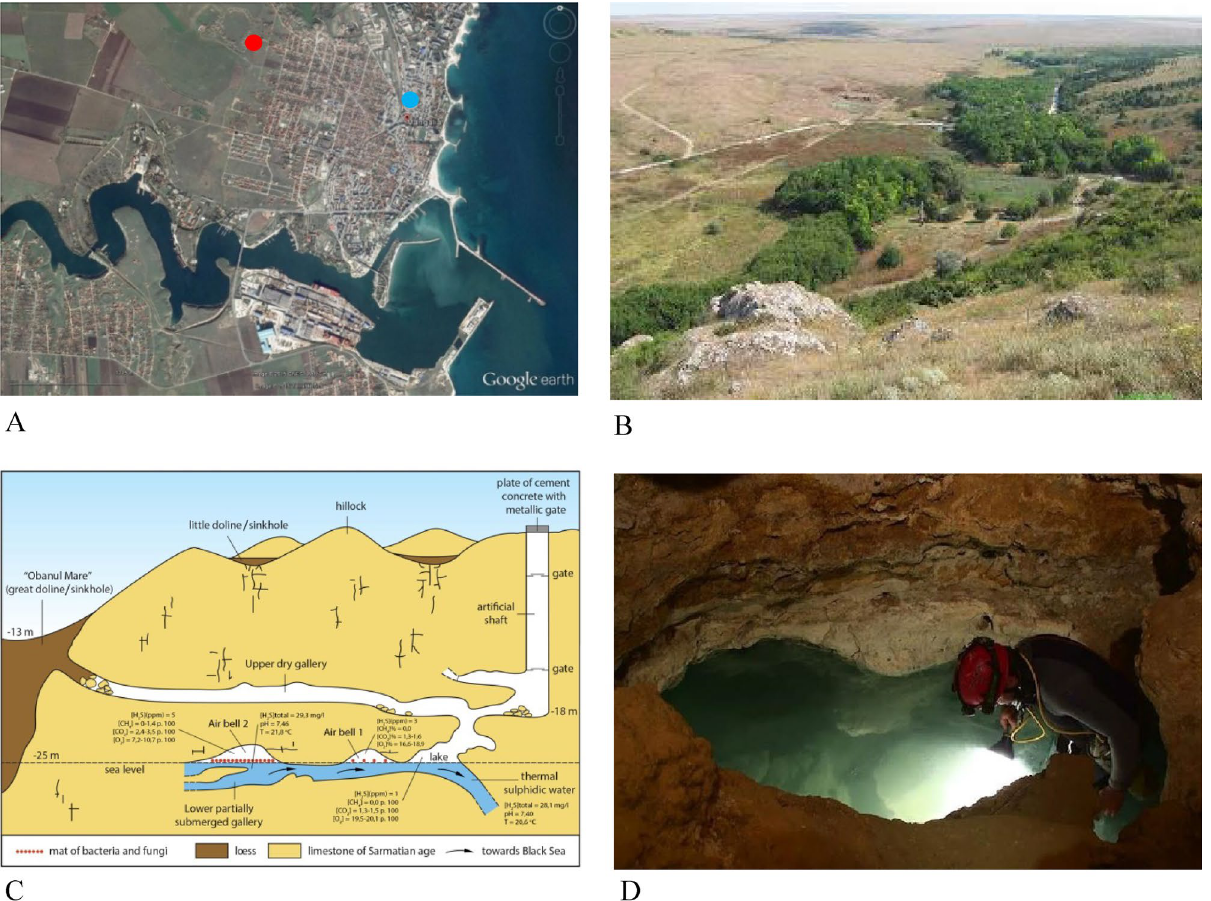
Figure 5. Location of Movile Cave near Mangalia (south eastern Romania). ( A ) Location of Movile Cave (red dot) and the hand-dug well in Mangalia village (blue dot). ( B ) Landscape around Movile Cave. ( C ) Profile of Movile Cave (map after Sarbu, 2000). ( D ) Lake Room from where the specimens were